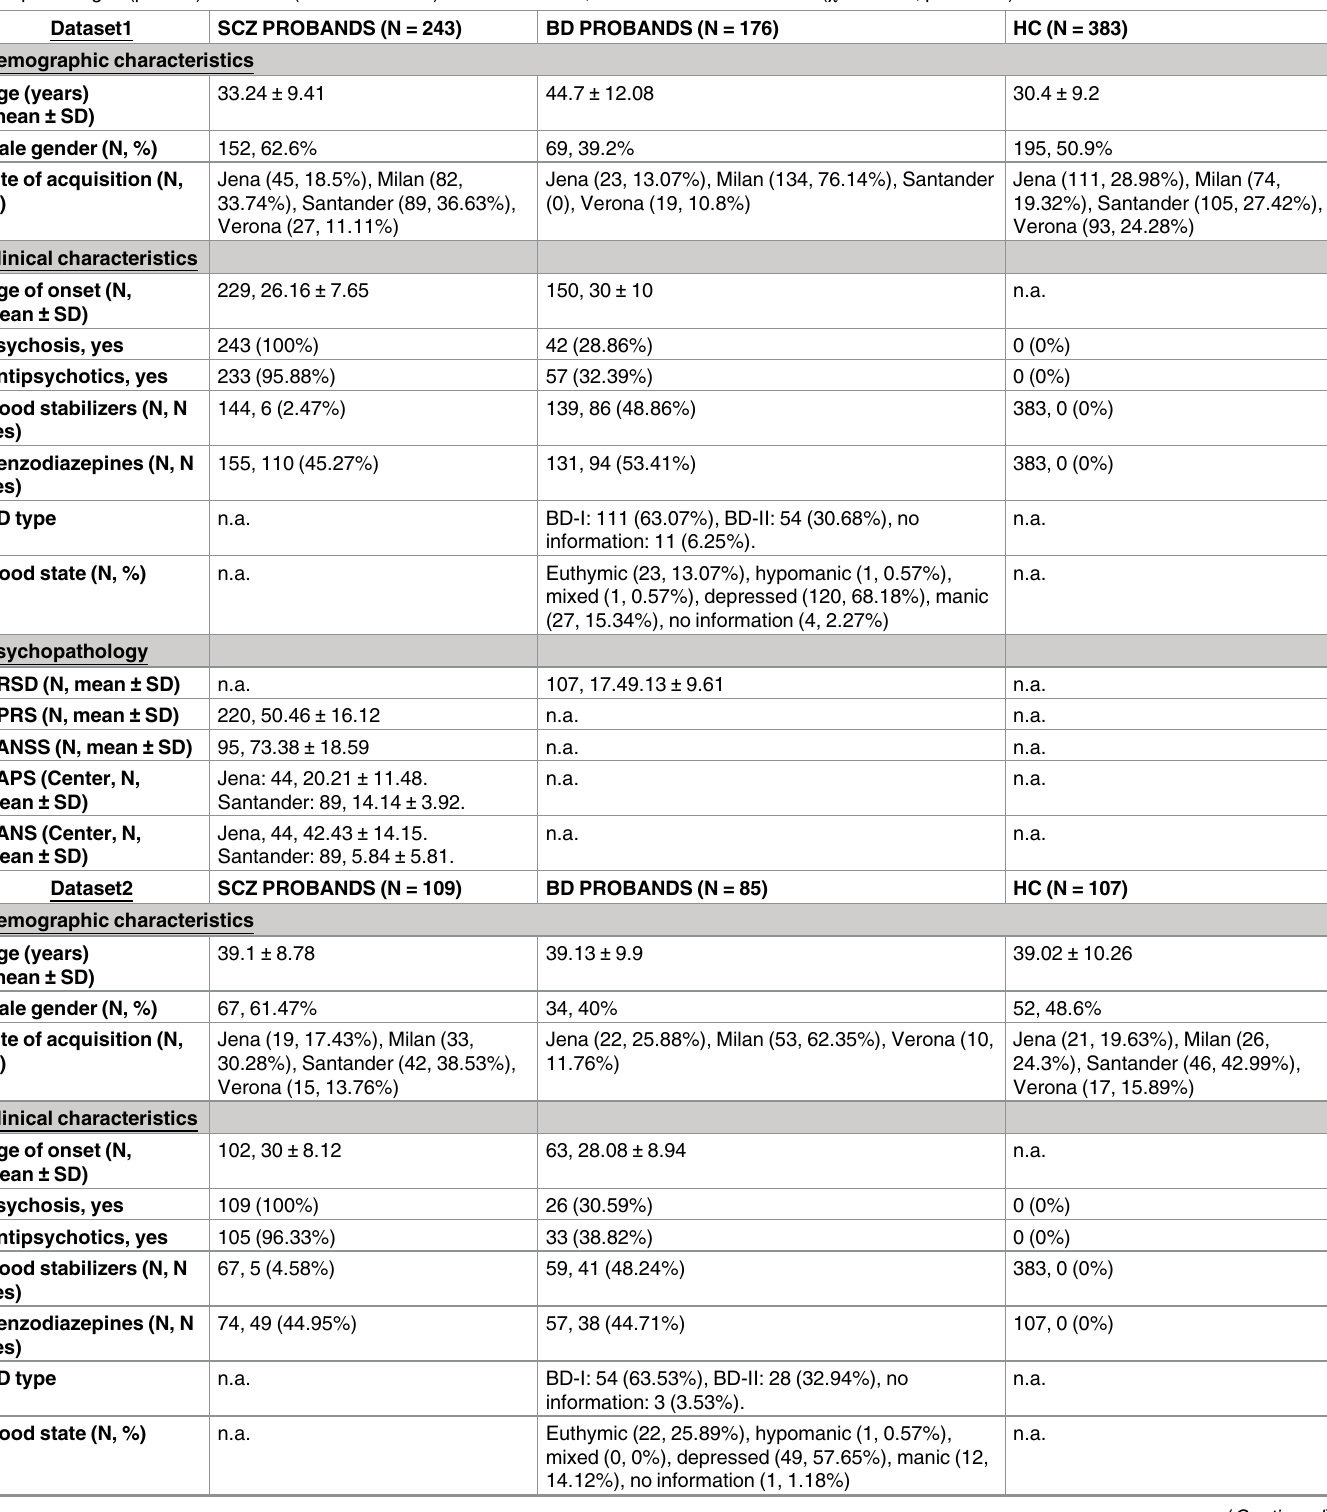
Table 1. Demographic and clinical details in the two datasets. In Dataset1, from the analysisof variance(ANOVA), significantage differences across groups emerged (p < 0.01).Sex ratio (Males/Females) was 1.67 in SCZ, 0.64 in BD and 1.04 in HC ( χ 2 = 23.02, p < 0.0001).